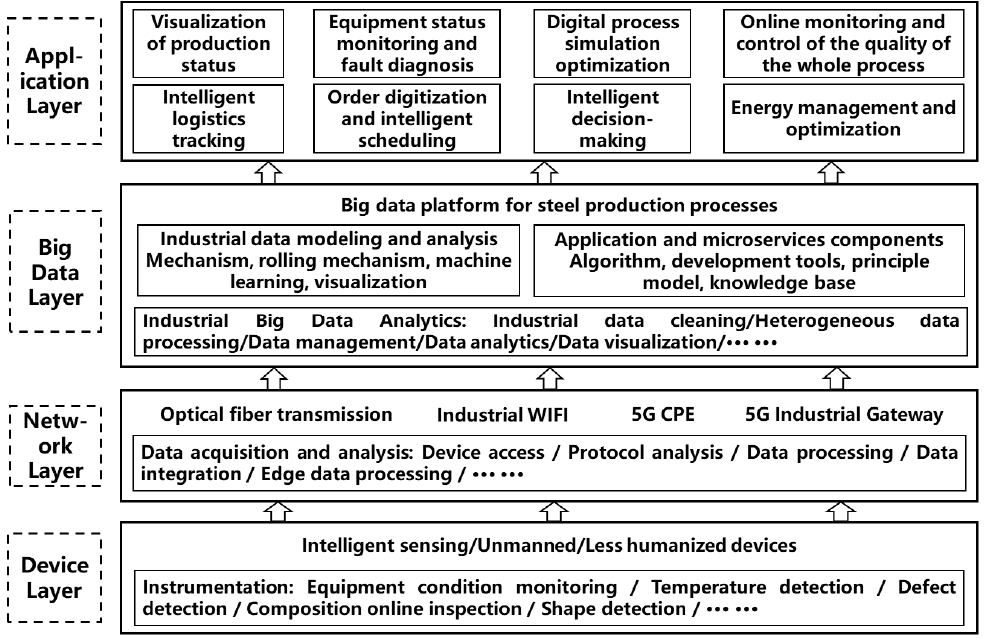
Figure 2. Framework for intelligent manufacturing in China’s steel industry.